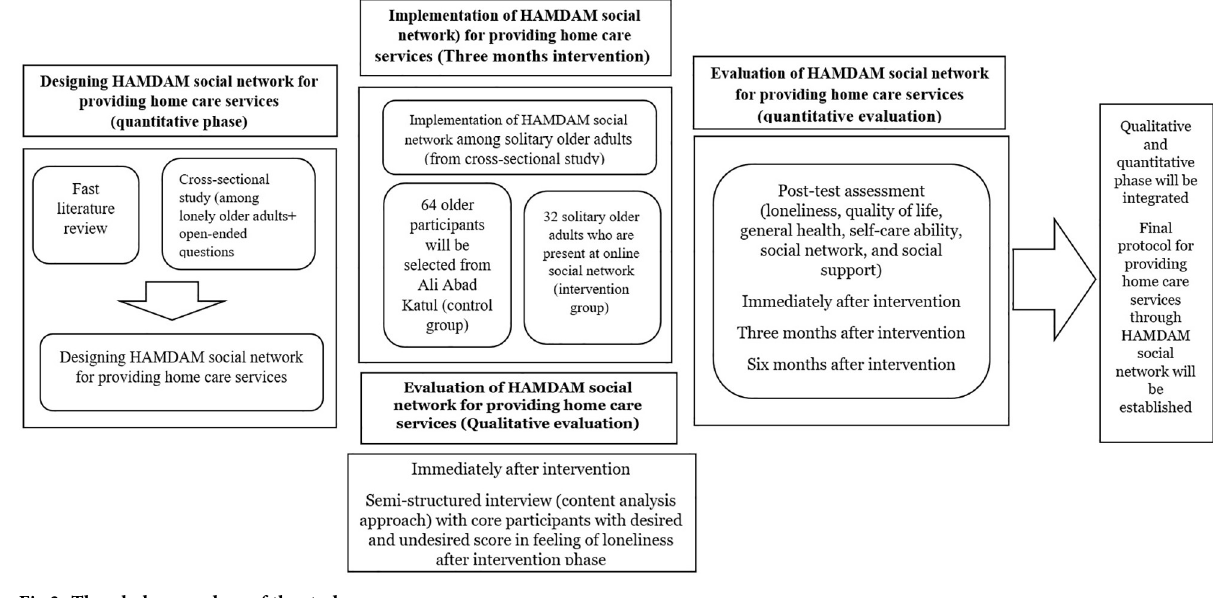
Fig 3. The whole procedure of the